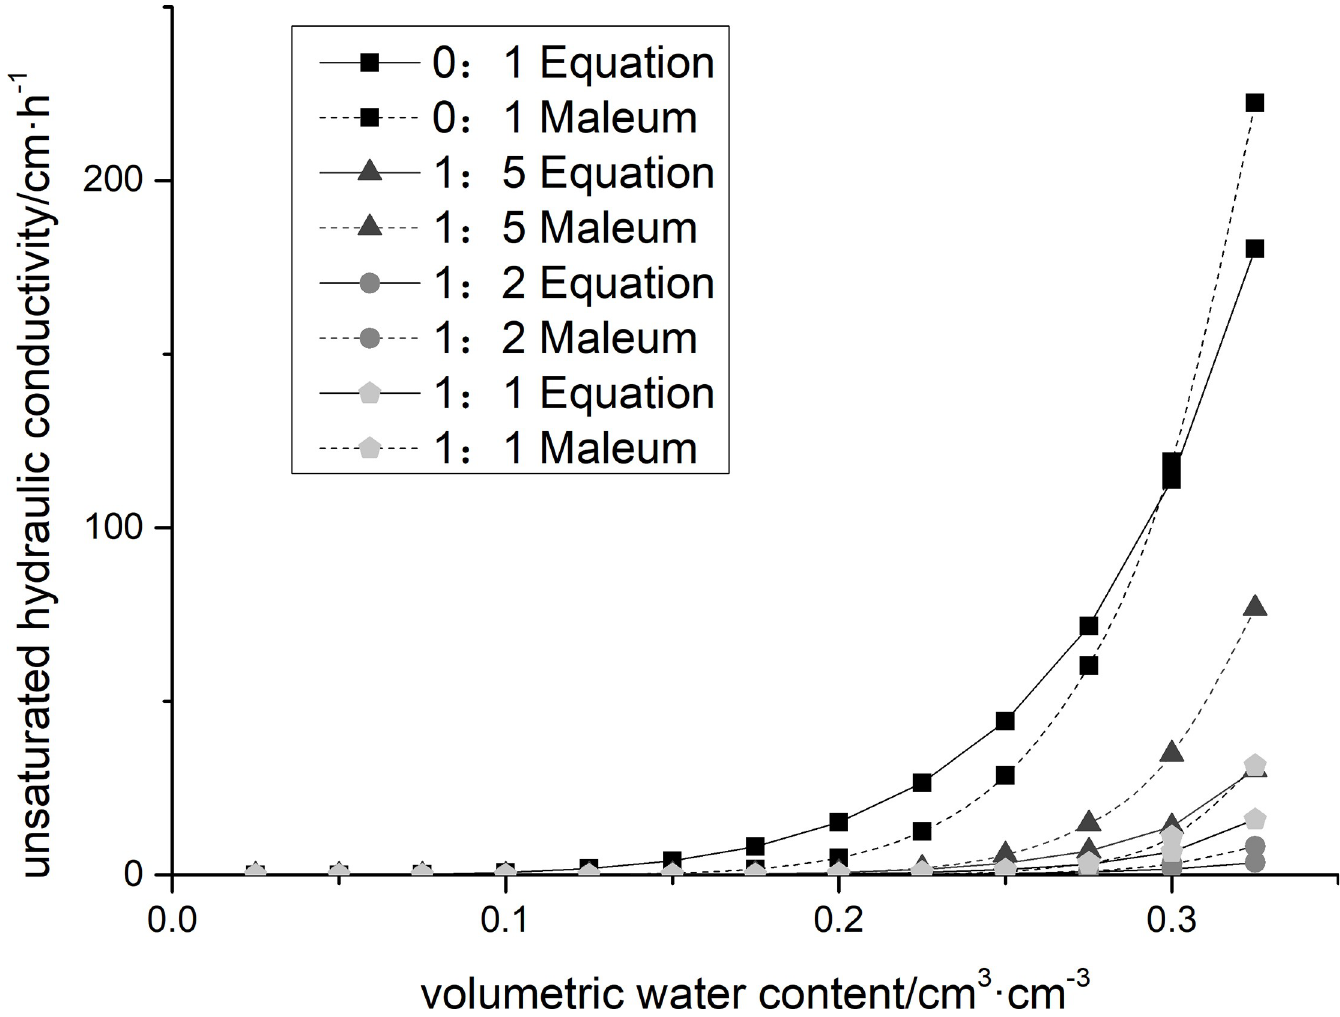
Fig 3. Comparison of predicted and measured parsing hydraulic conductivity after soft rock